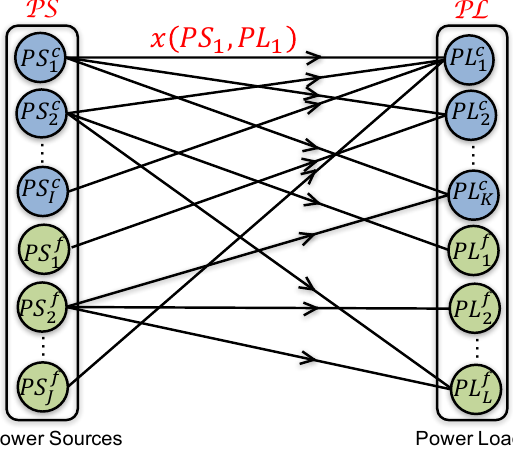
Figure 3. Representation of power sources, power loads, and connections between them using bipartite graph.